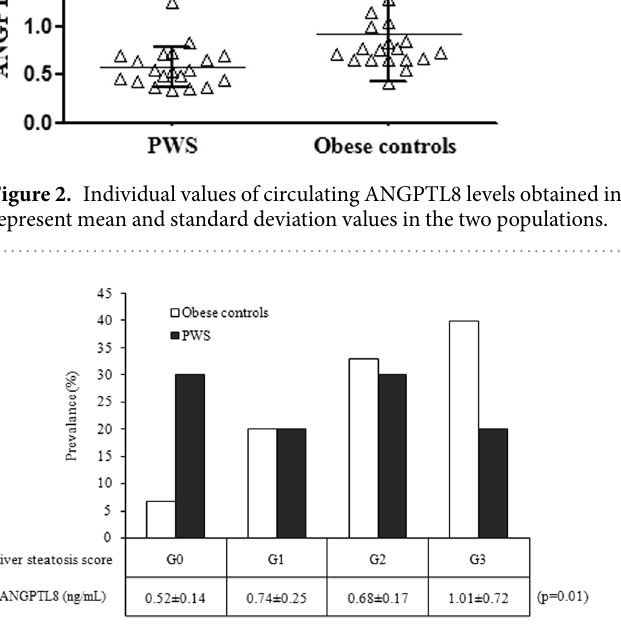
Figure 3. Histogram illustrating the prevalence (%) of liver steatosis in PWS and obese controls, and the corresponding ANGPTL8 levels across liver steatosis scores as obtained in the two population as a whole. Significance is expressed as obtained by ANOVA. Inter-group differences are listed in the Results